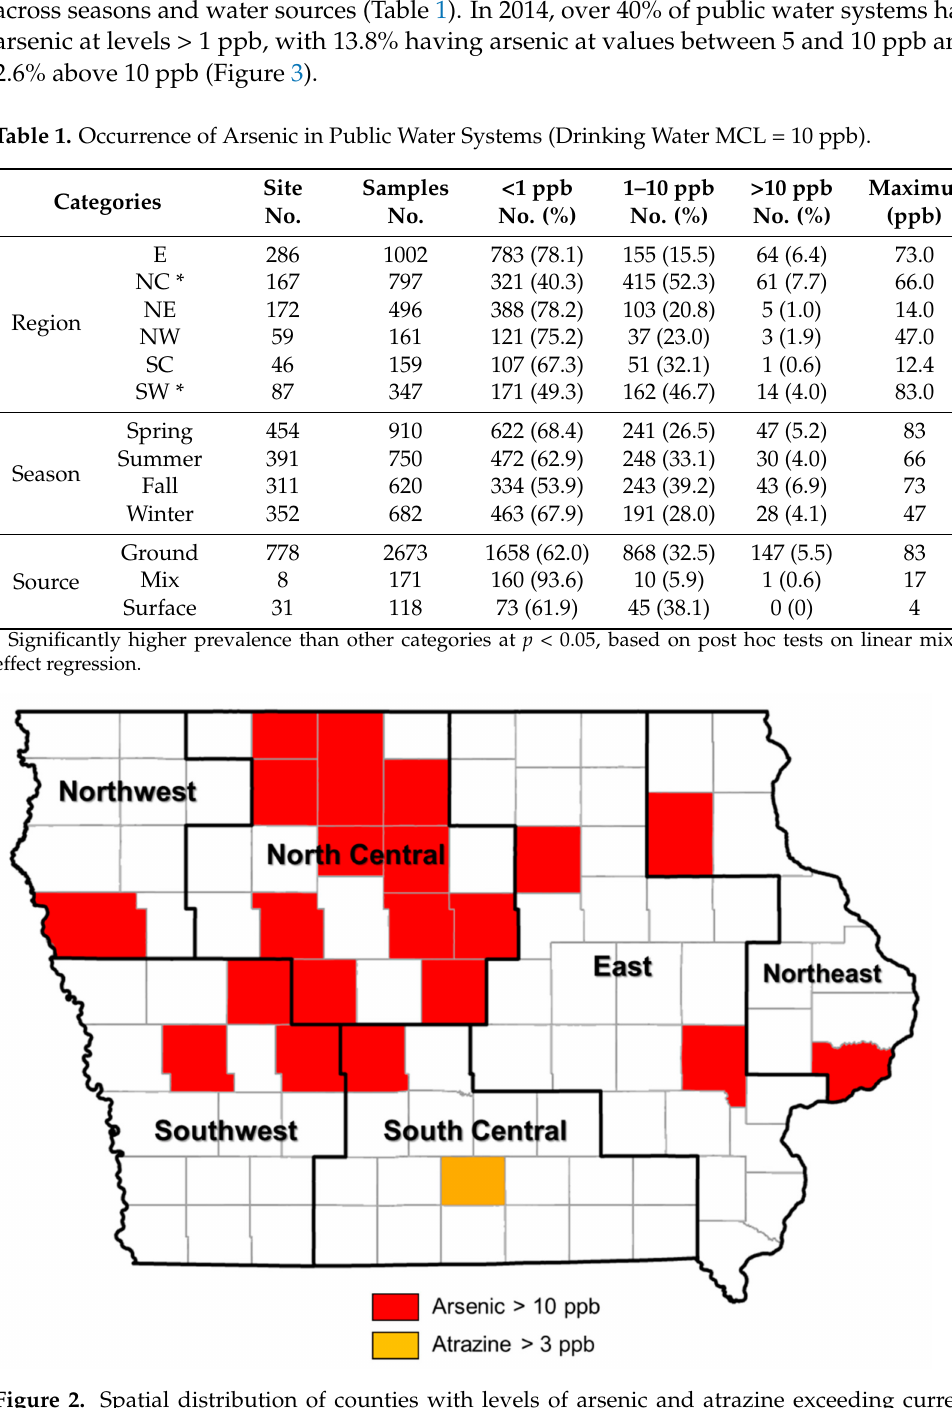
Figure 2. Spatial distribution of counties with levels of arsenic and atrazine exceeding current drinking water MCLs in PWS samples,